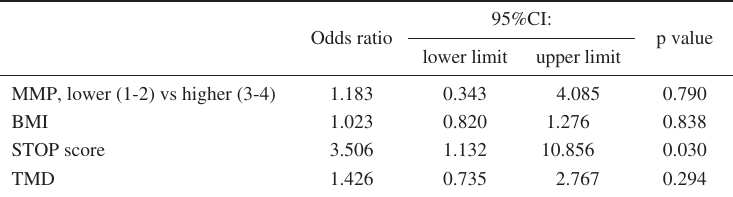
Table 3. Potential predictors of